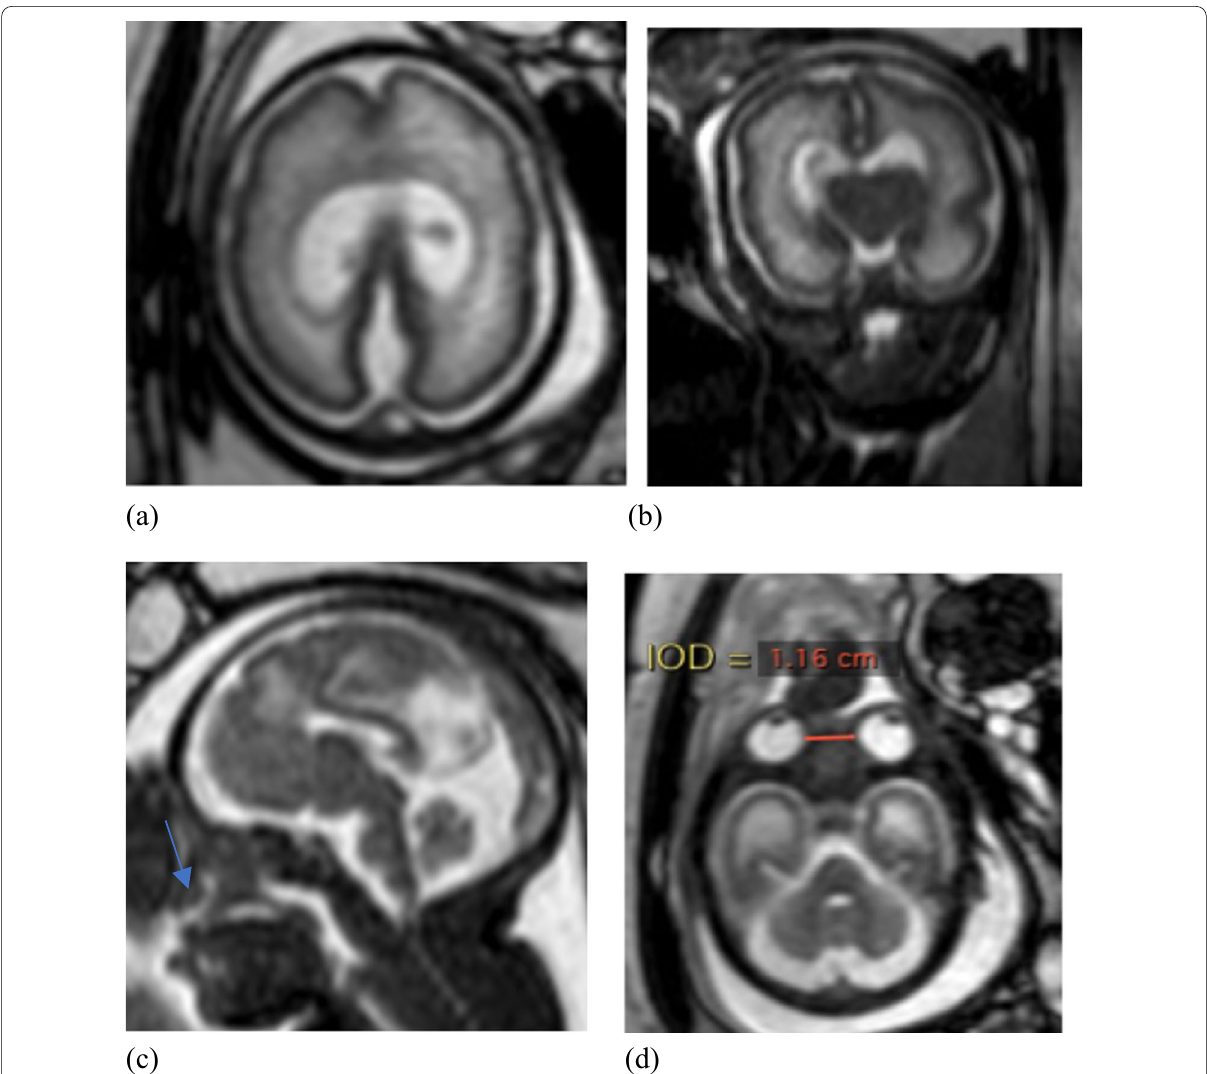
Fig. 1 Twenty-eight-week gestation; prenatal ultrasound revealed absent septum pellucidum; and mono-ventricle and unilateral cleft palate. SSFSE T2WIs axial and coronal planes at the level of lateral ventricle a , b revealed absent septum pellucidum with partially cleaved anterior cerebrum and abnormal configuration of lateral ventricles that appears as mono-ventricle with partially developed occipital and temporal horns, but deficient frontal horns and incomplete falx cerebri. Incompletely formed interhemispheric fissure, especially anteriorly. Attempts of 3rd ventricle formation with partially fused thalami. Smooth surface of the brain with minimal attempts of sulcation. Sagittal plane ( c ) showed the most posterior portion of corpus callosum is seen with deficient anterior part. Sagittal and axial planes c , and d revealed midline facial anomalies in the form of hypotelorism [IOD 12 mm (< 5% percentile), (N for GA 17.7 mm)] and unilateral cleft lip (arrow). MRI diagnosis: Semi-lobar holoprosencephaly associated = = with lissencephaly and facial anomalies in the form of hypotelorism and cleft lip. Recommendation: Termination of